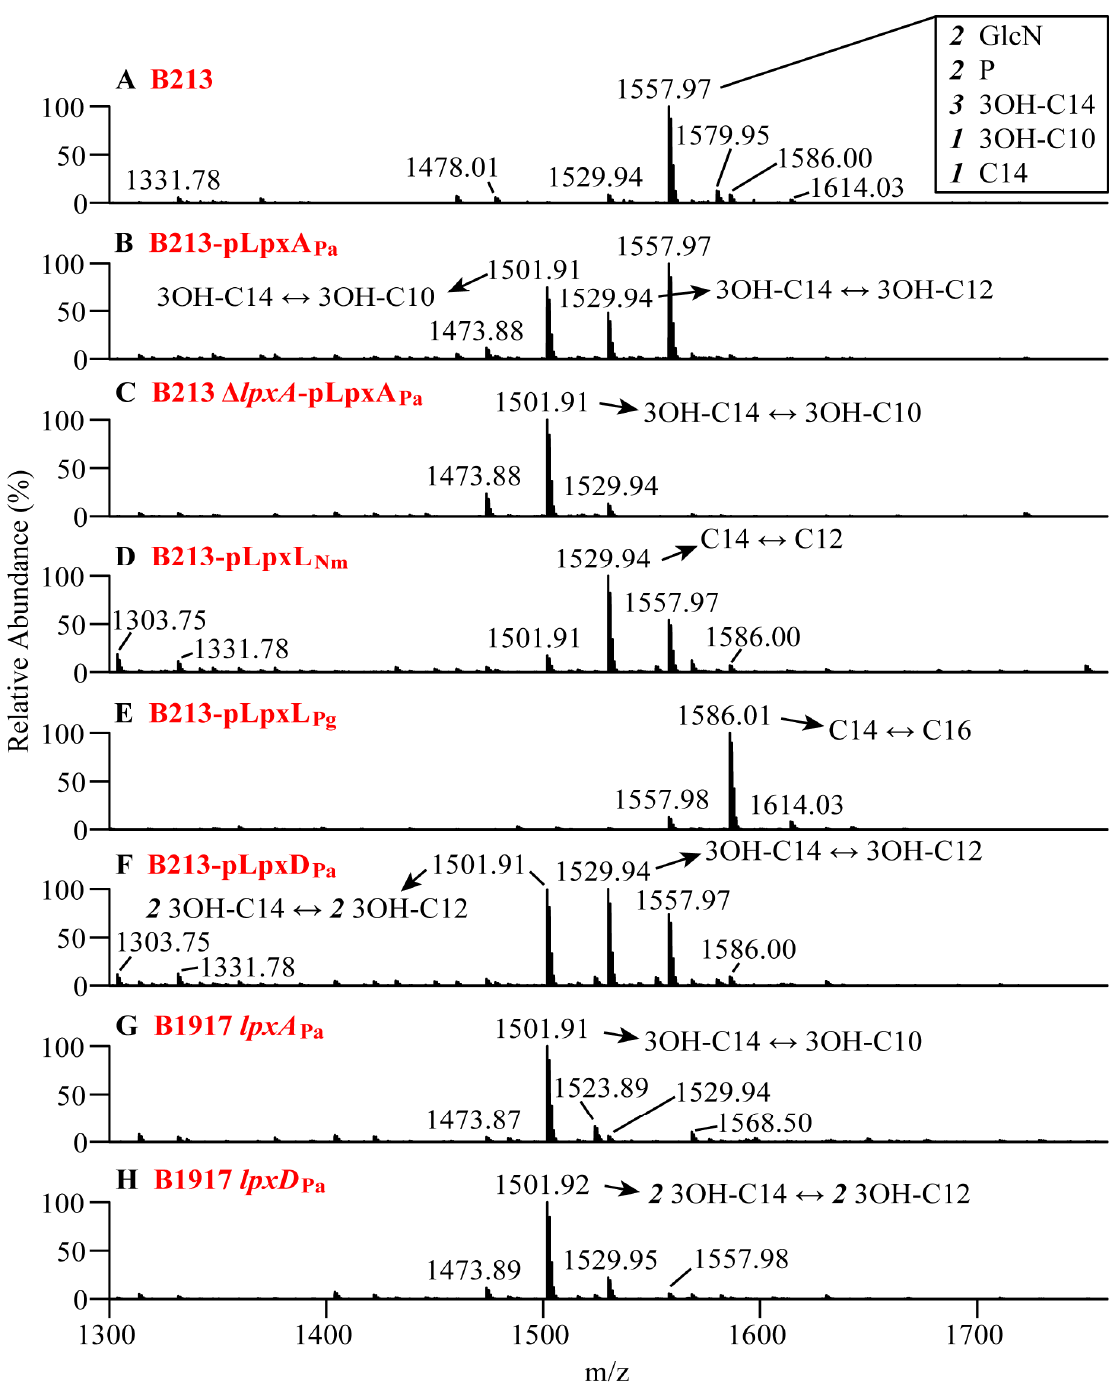
Figure 2. Structural analysis of lipid A by ESI-MS. Negative-ion lipid A mass spectra